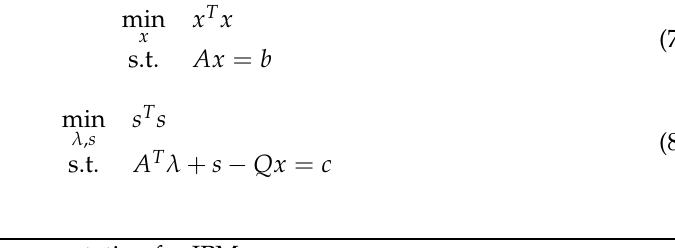
Algorithm 1 Starting point computation for